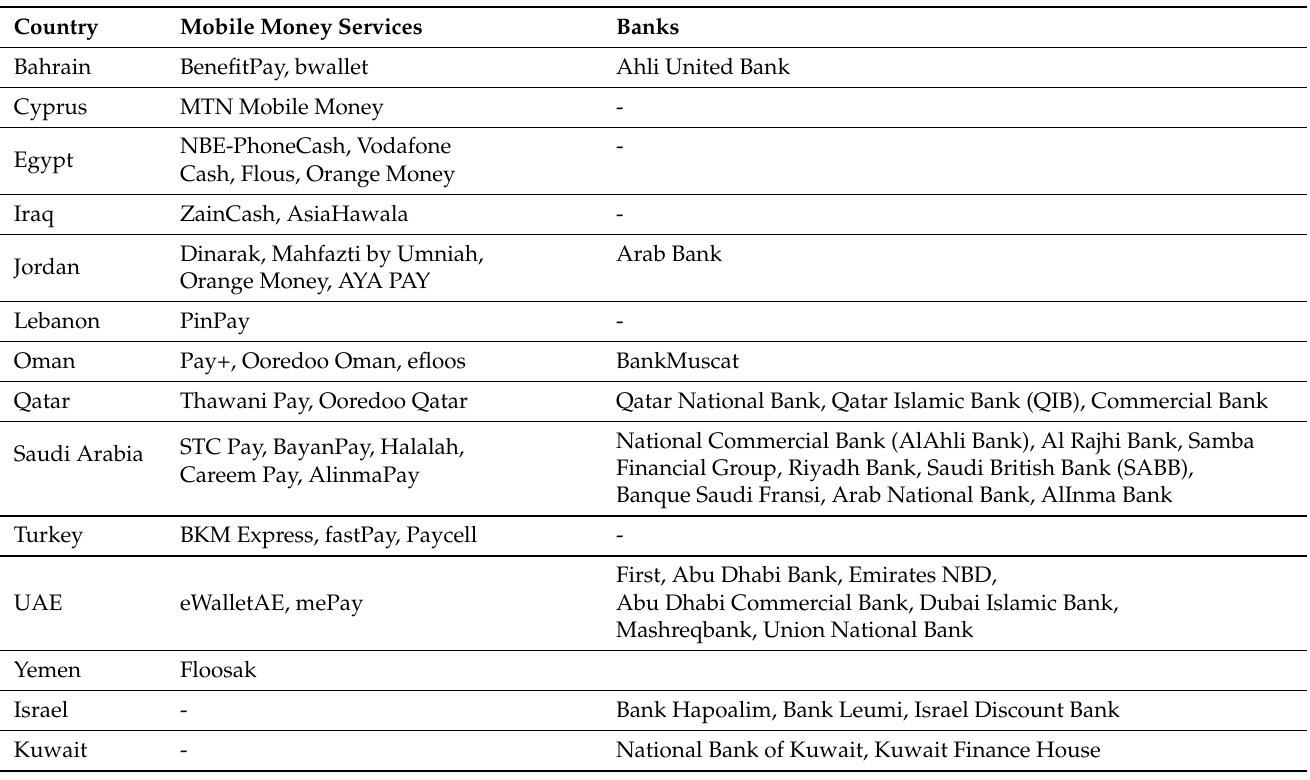
Table 1. Middle Eastern Banks and Mobile Money Services